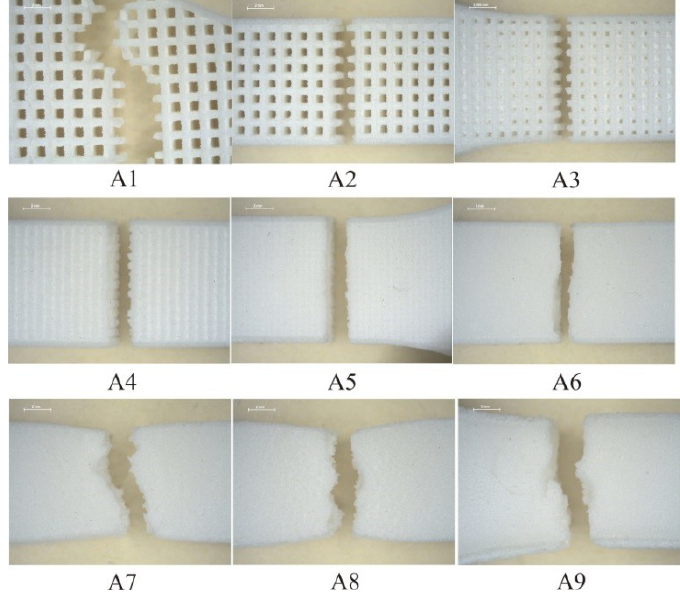
Figure 12. Microscopy images of fracture surface.